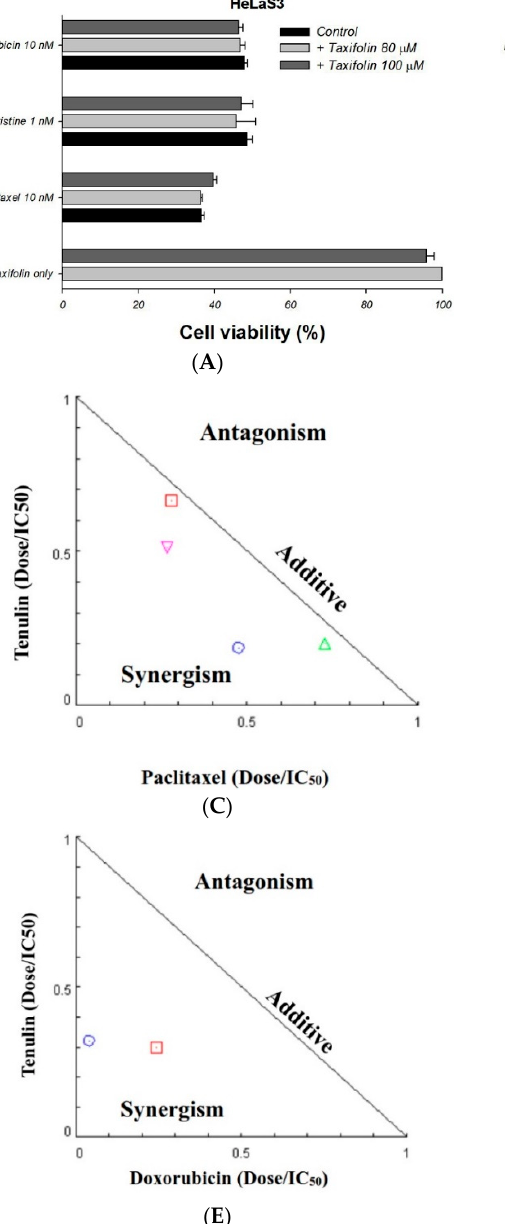
Figure 3. Resistance-reversal ability of taxifolin on MDR cancer cell line. ( A , B ) Cytotoxicity was conducted by SRB assay in HeLaS3 and KB-vin cell lines. Taxifolin significantly increased the cytotoxicity of paclitaxel, vincristine, and doxorubicin as compare to each chemotherapeutic agent alone. ( C – E ) The combination index represented the additive or synergistic effect of the combination treatment of taxifolin and chemotherapeutic agents. Data presented as mean ± SE of at least two experiments, * denotes p < 0.05 compared with alone treatment.